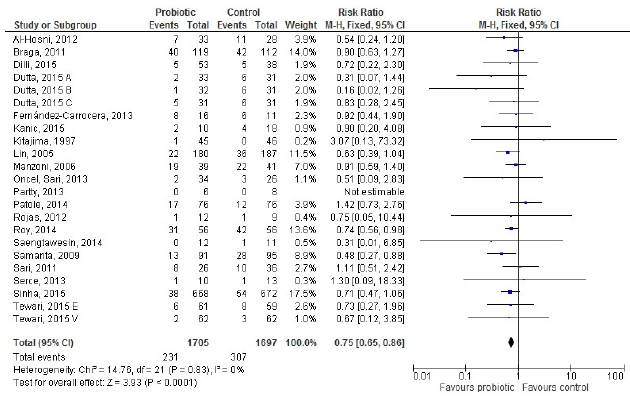
Figure 3. The forest plot shows the association between the use of probiotics and late onset sepsis in the twenty studies reporting data for exclusively human milk-fed preterm infants. M–H: Mantel–Haenszel method.